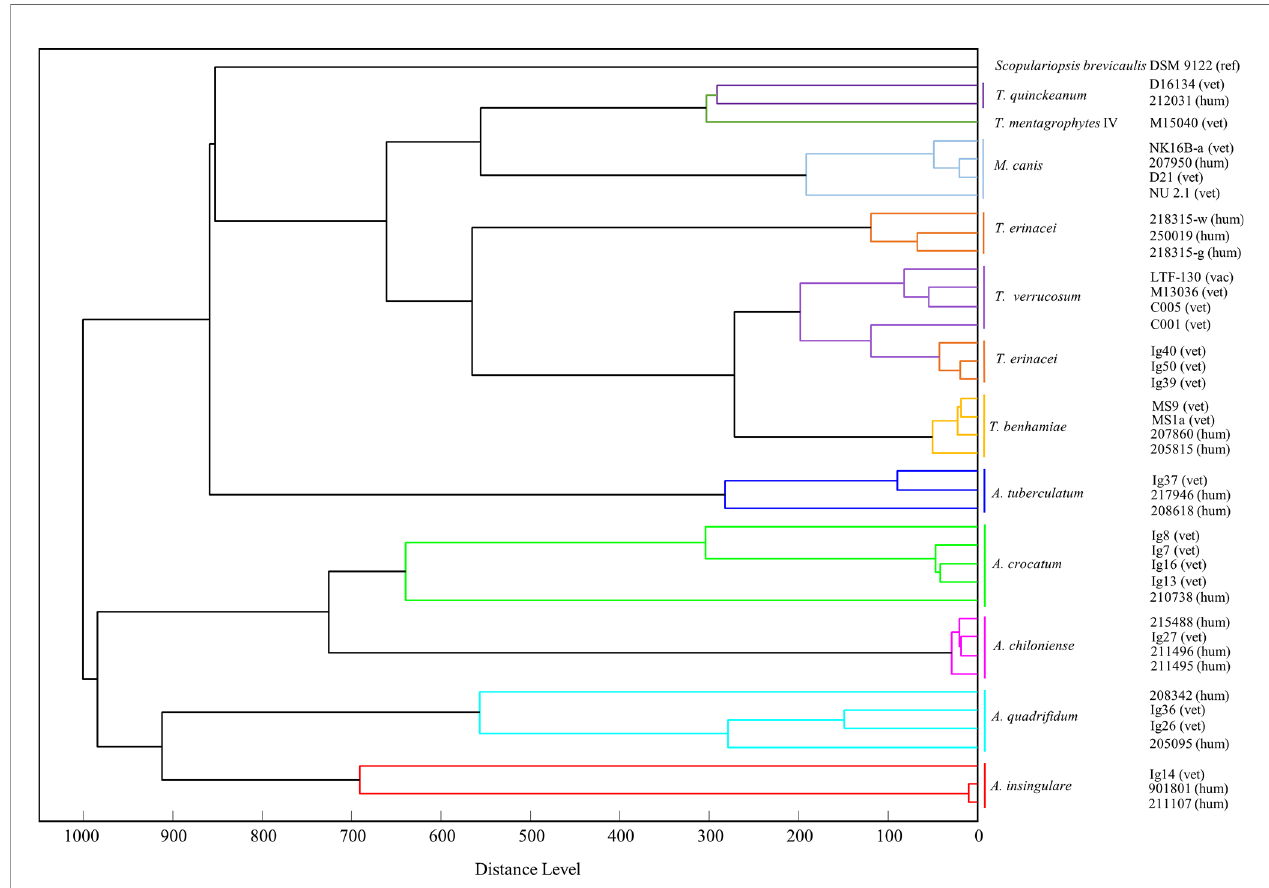
FIGURE 5 | A score-oriented distance dendrogram based on the mass spectrometric data (MSP) was generated to identify similarities and clusters of closely related zoophilic and geophilic dermatophytes (Distance Measure Correlation mode, MBT Compass Explorer, Bruker Daltonik GmbH). Isolates of Trichophyton (T.) erinacei, Arthroderma (A.) spp. as well as others from the genera Trichophyton and Microsporum , respectively, from animal (vet, vac) and human patients (hum) were included (ref - reference, derived from NCBI database). The different species cluster in two main clades: the lower one comprises geophilic isolates only, i.e. A. insingulare, A. quadri fi dum, A. chiloniense and A. crocatum . The isolates of A. tuberculatum group into the upper clade but therein in the lowest position, i.e. closest to the other Arthroderma spp. The upper clade further comprises the Trichophyton spp. and the M. canis -isolates (and S. brevicaulis ). All T. erinacei, T. verrucosum and T. benhamiae- isolates form one subclade indicating their close relation. Species identity was previously con fi rmed by sequencing of the ITS region of fungal